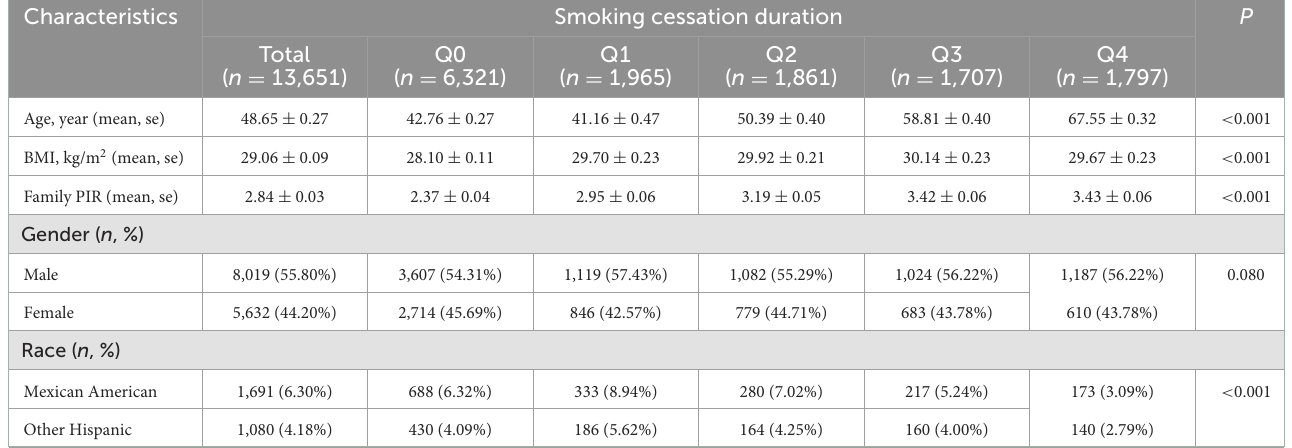
TABLE 7 Baseline characteristics of participants with smoking